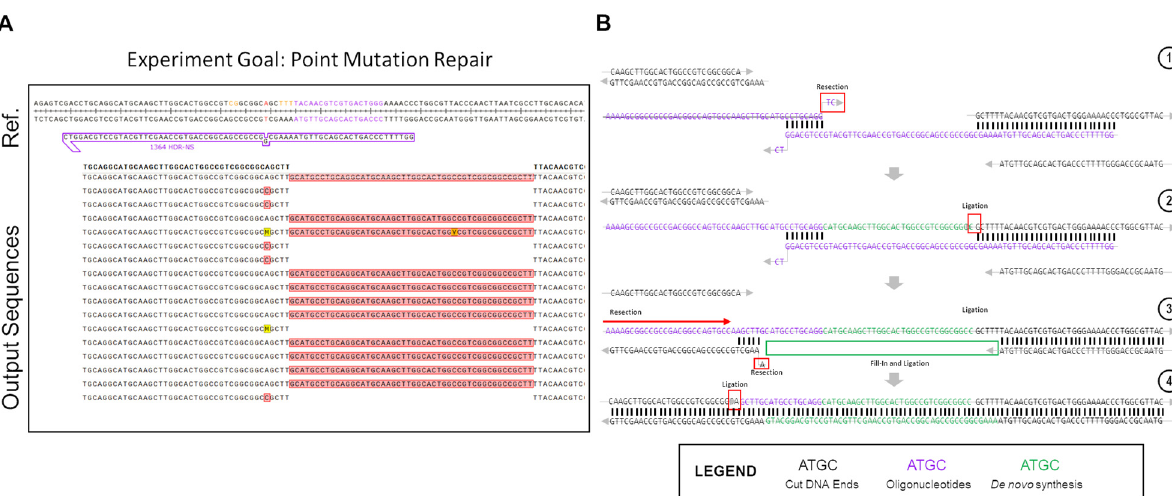
Figure 2. Atypical repair outcomes caused by ssODN dimerization in in vitro gene editing. The partial outcome data of one gene editing reaction, carried out using Cas12a in the in vitro system, are shown here. ( A ) The experimental results. The LacZ gene was repaired with a semi-symmetrical oligo, with one 40 bp and one 29 bp homology arm, with a single base repair (A > C) in the middle. ( B ) Depiction of the pathway of repair that led to the 48 bp insertions seen in the experimental output. ( 1 ) The dimerized ssODN (purple) associated with the cut DNA ends (black) in order to facilitate the generation of the products seen. ( 2 ) The dimerized ssODN created a makeshift gap that allowed for DNA synthesis to fill in according to the template (green). Ligation occurs after the green bases are synthesized, incorporating the actual oligo into the top strand of the downstream end as a long 5 ′ -overhang. ( 3 ) After ligation, the unincorporated ssODN dissociates from the complex, and the newly-extended 5 ′ -overhang associates with a 5bp stretch of microhomology on the upstream end of the cut site. The 5 ′ -end upstream of this microhomology patch is resected or cleaved, as well as the single mismatched base on the exposed 5 ′ -end of the bottom strand. ( 4 ) Ligation occurs after resection on the top strand, leading to a complete top strand. The bottom strand, meanwhile, is filled in via synthesis, using the top strand as a template.